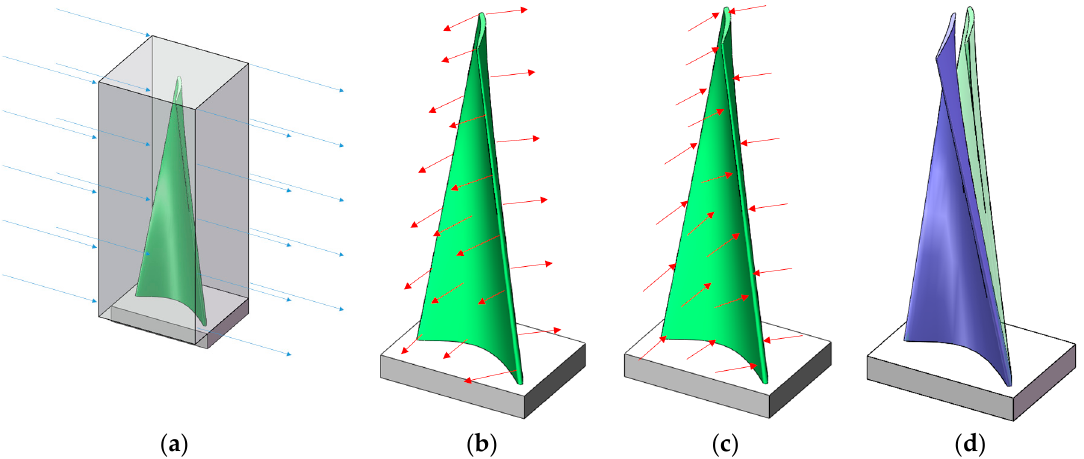
Figure 1. Process of obtaining the initial cold shape. ( a ) Flow field around the ideal shape; ( b ) aerodynamic load acting on the ideal shape; ( c ) aerodynamic load reversely applied to the ideal shape; ( d ) initial cold shape.